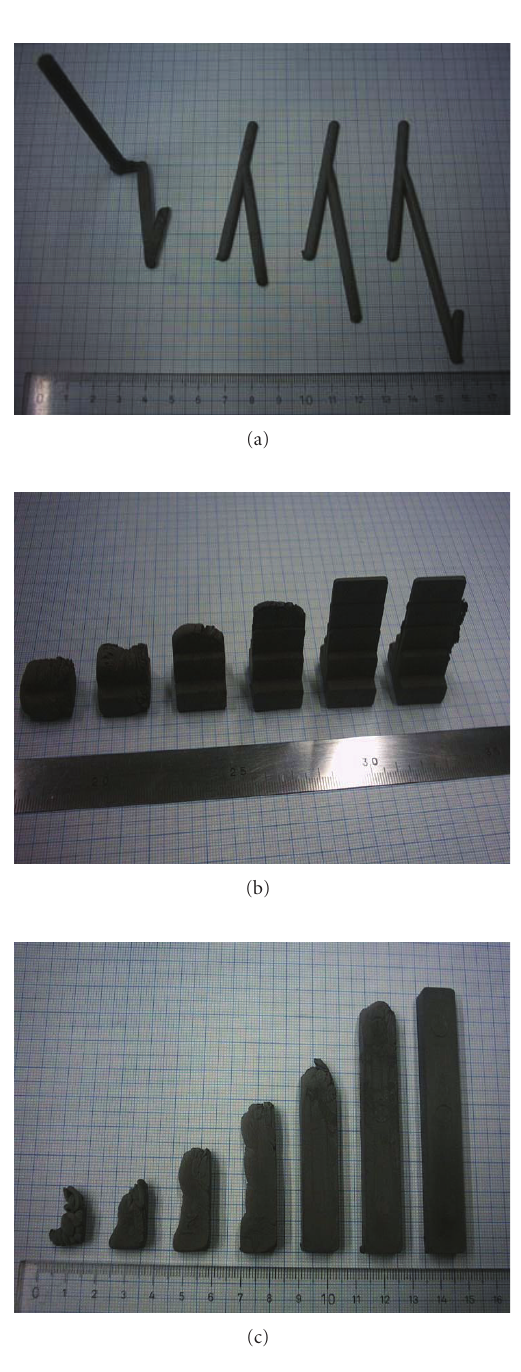
Figure 14: Pressed 316L stainless steel samples: (a) zigzag flow test, (b) five stepped part, (c) rectangular prism part.